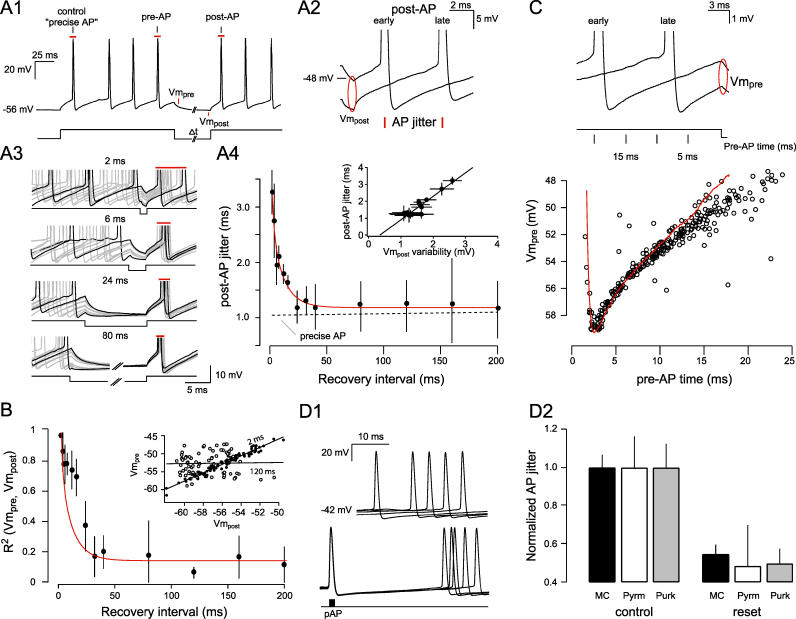
Hyperpolarizations Maintain AP Precision by Minimizing Membrane Potential Variance(A1) Schematic showing the experimental configuration and analysis parameters of the mitral cell membrane voltage recorded while varying the hyperpolarization period (Δt; 2 to 400 ms). AP jitter was created by injecting a depolarizing current pulse (150 to 250 pA for 100 ms) and estimated by calculating the standard deviation of the pre-AP time. The effect of the hyperpolarizing pulse on precision recovery was measured by determining the jitter of the AP immediately following the hyperpolarization pulse (post-AP) and comparing it to the control AP. The relationship between membrane potential at the beginning (Vm
pre) and at the end (Vm
post) was determined by calculating the mean voltage over the first 250 μs and the last 100 μs of the nonspiking interval.
(A2) Two example traces of a 2-ms hyperpolarizing pulse with post-APs showing that depolarized (−48 mV) and hyperpolarized (−58 mV) potentials evoked early and late post-APs, respectively. The red ellipse highlights the variable membrane potential at the end of the hyperpolarizing pulse; red lines indicate the variable AP times of the post-AP that reflect post-AP jitter.(A3) Representative voltage traces of APs for hyperpolarization intervals of 2, 6, 24, and 80 ms show a large variation in Vm
pre (see also C); traces with the earliest and the latest prehyperpolarization AP are highlighted in black. Ten overlaid traces show the reduction in the variable membrane potential across the recovery period. The associated reduction in post-AP jitter is indicated by the red bars above the clipped APs.
(A4) Post-AP jitter as a function of the recovery interval (mean ± SEM,
n = 4 cells). The data points were fitted with a single exponential (τ = 6.8 ms). The precision of the control AP is indicated by the dashed line. Inset: Correlation between the post-AP jitter and membrane potential variance at Vm
post (
R
2 = 0.86).
(B) The correlation between Vm
pre and Vm
post plotted as a function of the recovery interval (
n = 4). The graph is overlaid by the single exponential fit shown in A4 (red line). Inset: The Vm
pre and Vm
post values are plotted for a 2-ms interval (filled circles) and compared to that for a 120-ms interval (open circles).
(C) (Top) Example traces showing the relationship between the pre-AP time (relative to the pulse onset) and Vm
pre. (Below) A plot of Vm
pre against pre-AP time for a single cell. A single AHP trace is superimposed on the graph.
(D1) Five consecutive traces from a mitral cell show spontaneous AP jitter relative to the same randomly chosen point in time (black) and the jitter of the AP (red) immediately following a precise AP (left). Cells were held at threshold by injecting constant current and the precise AP (pAP) was elicited by brief current injection (1,000 pA for 2 ms).(D2) Population data from mitral cells (
n = 6), pyramidal neurons (
n = 5), and Purkinje neurons (
n = 3) showing the normalized jitter of ongoing APs and the AP immediately following the injected pAP (mean ± SEM,
p < 0.001 in all cell types). Precision recovery is similar in the three cell types.